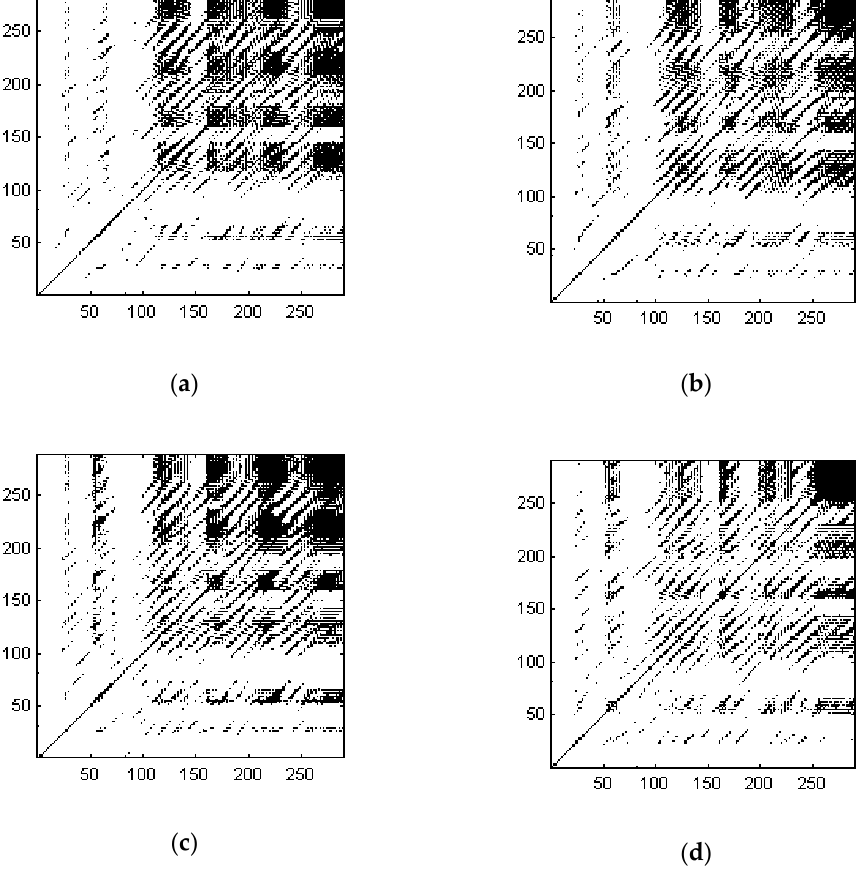
Figure 8. Recurrence plots (RPs) of the second half of backscattered signals of Defect-free-1. ( a ) signal 1 ( b ) signal 2 ( c ) signal 3 ( d ) signal 4.